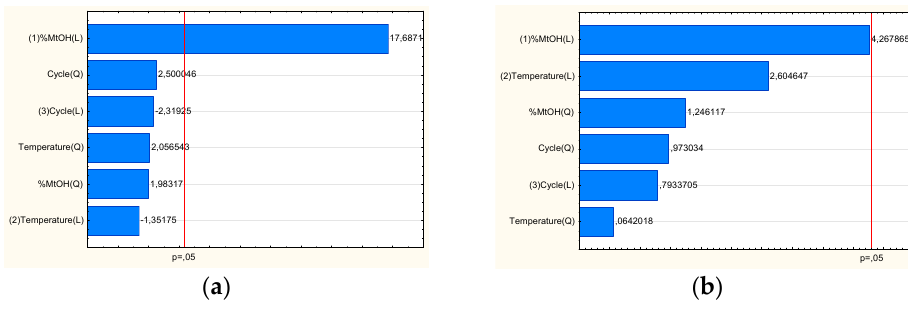
Figure 2. Pareto plot of standardized effects for the baicalin content ( a ) and TPC ( b ).